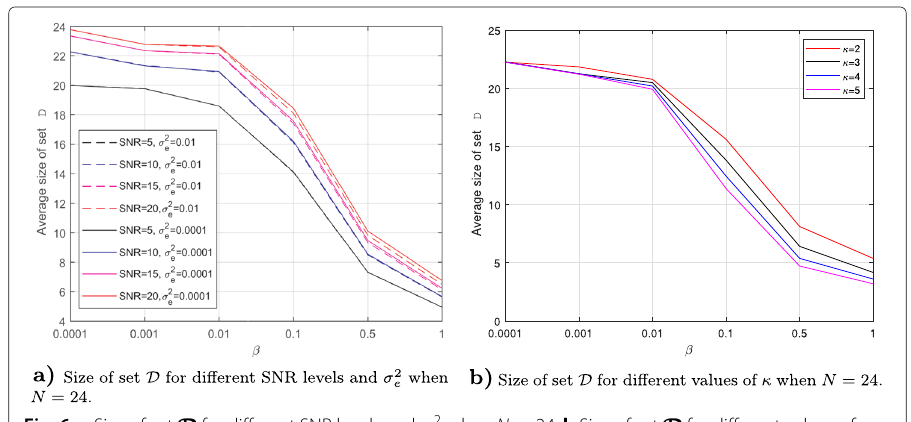
Fig. 6 a Size of set D for different SNR levels and σ 2 e when N = 24. b Size of set D for different values of κ when N =